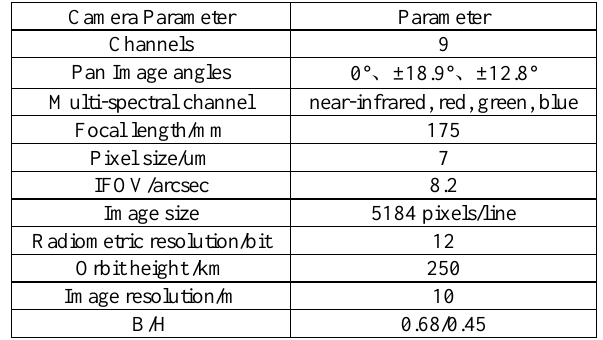
Figure 1. Line array arrangement of HRSC camera The panchromatic image of HRSC has the merit of high spatial resolution but it is lack of spectral information. While the multi- spectral image of HRSC has the merit of abundant spectral information, whereas it has a low spatial resolution. Therefore, a high spatial resolution multi-spectral image can be fused. Before the image can be fused, panchromatic and multi-spectral image of HRSC need to be geometrically rectified firstly. In order to get high accuracy and proper registered images, the Table 1. Geometric parameters of HRSC camera rigorous geometric model is adopted in image rectification. The Level 2 data of HRSC which pertain the original